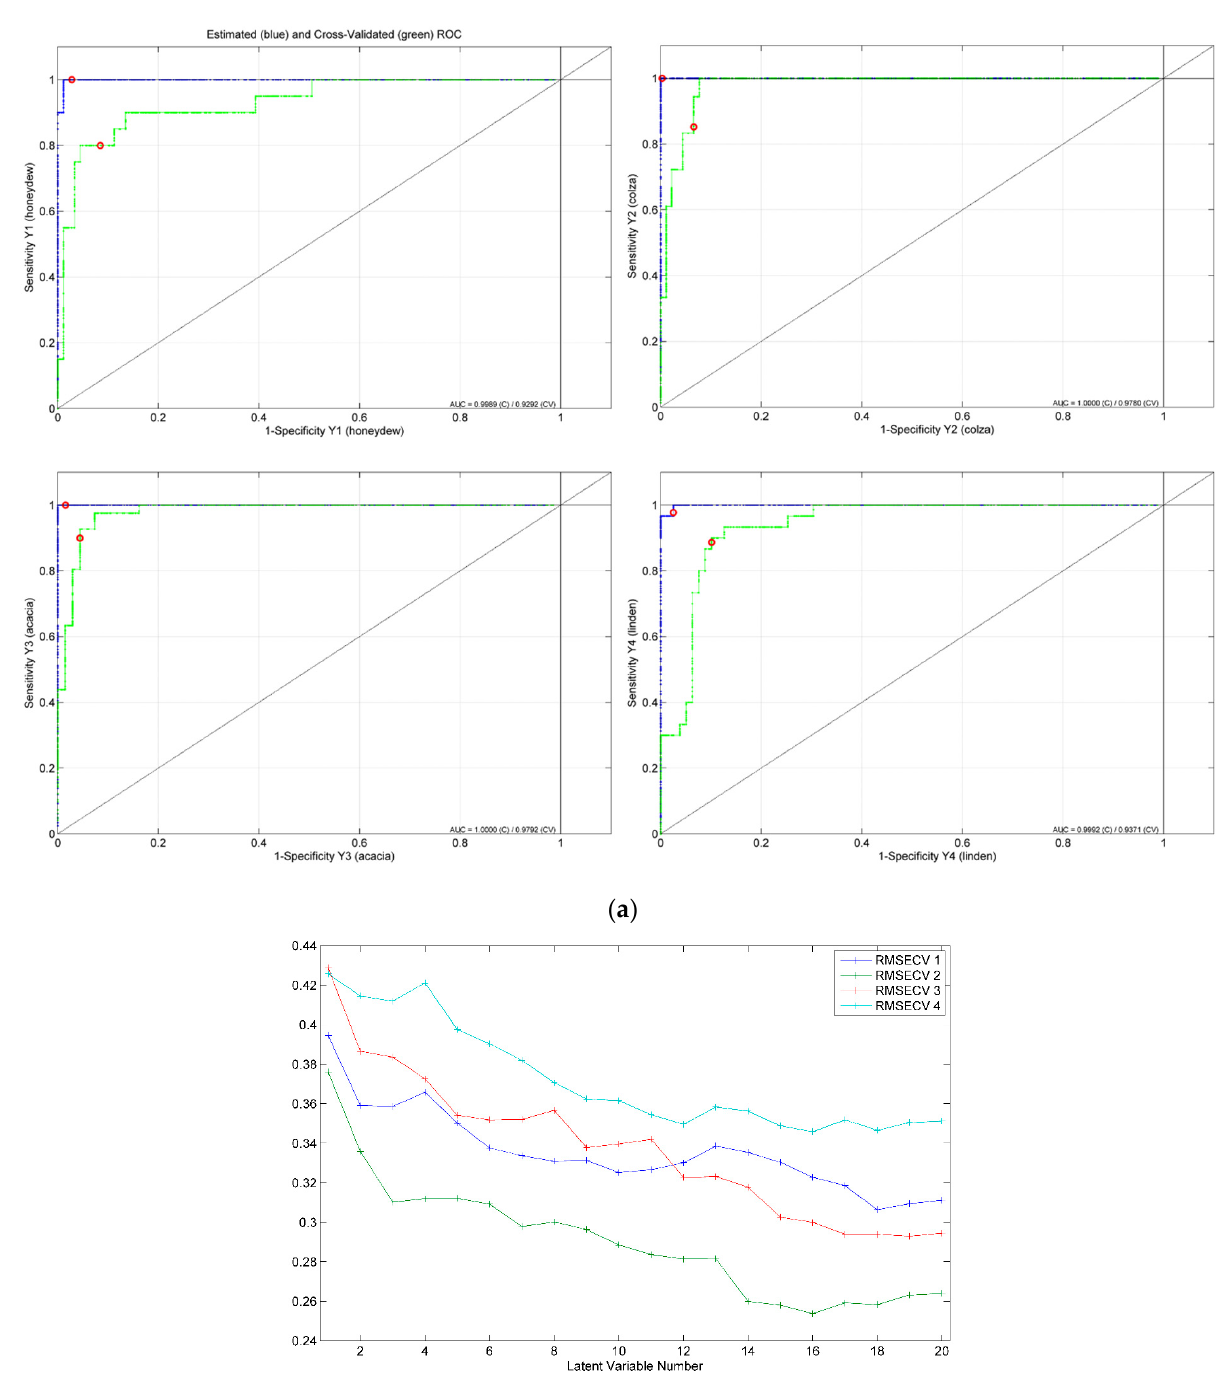
Figure 8. Score plot (LV1 vs. LV2 vs. LV3) associated with the PLS-DA model developed for the simultaneous differentiation of the four botanical honey classes (i.e., honeydew, colza, acacia and linden).